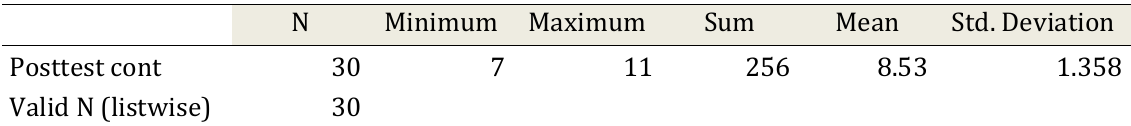
Table 4.26 Mean value of posttest Students' in Control Class Descriptive